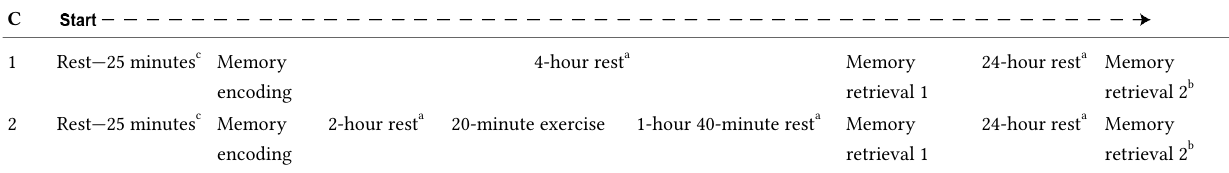
Study Protocol for Experiment